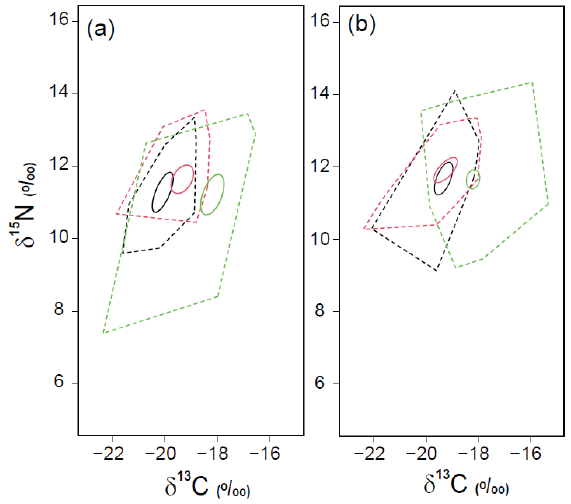
Figure 3. The isotopic niche areas (‰ 2 ) of fish assemblages collected at the sampling sites (black lines, St. A; red lines, St. B; green lines, St. C) in May ( a ) and October ( b ) estimated as total area (TA, dotted line) and standard ellipse area (SEAc, solid line). Table 5. δ 13 C and δ 15 N values and trophic position (TP) of fish consumers collected at the St. A, St. B, and St. C during October 2020. Lower case codes indicate feeding modes (b, benthic feeder; bp, benthopelagic feeder; p, pelagic feeder). The lipid-correction was applied for the δ 13 C of marked species (*). Data represent mean ± 1 SD.